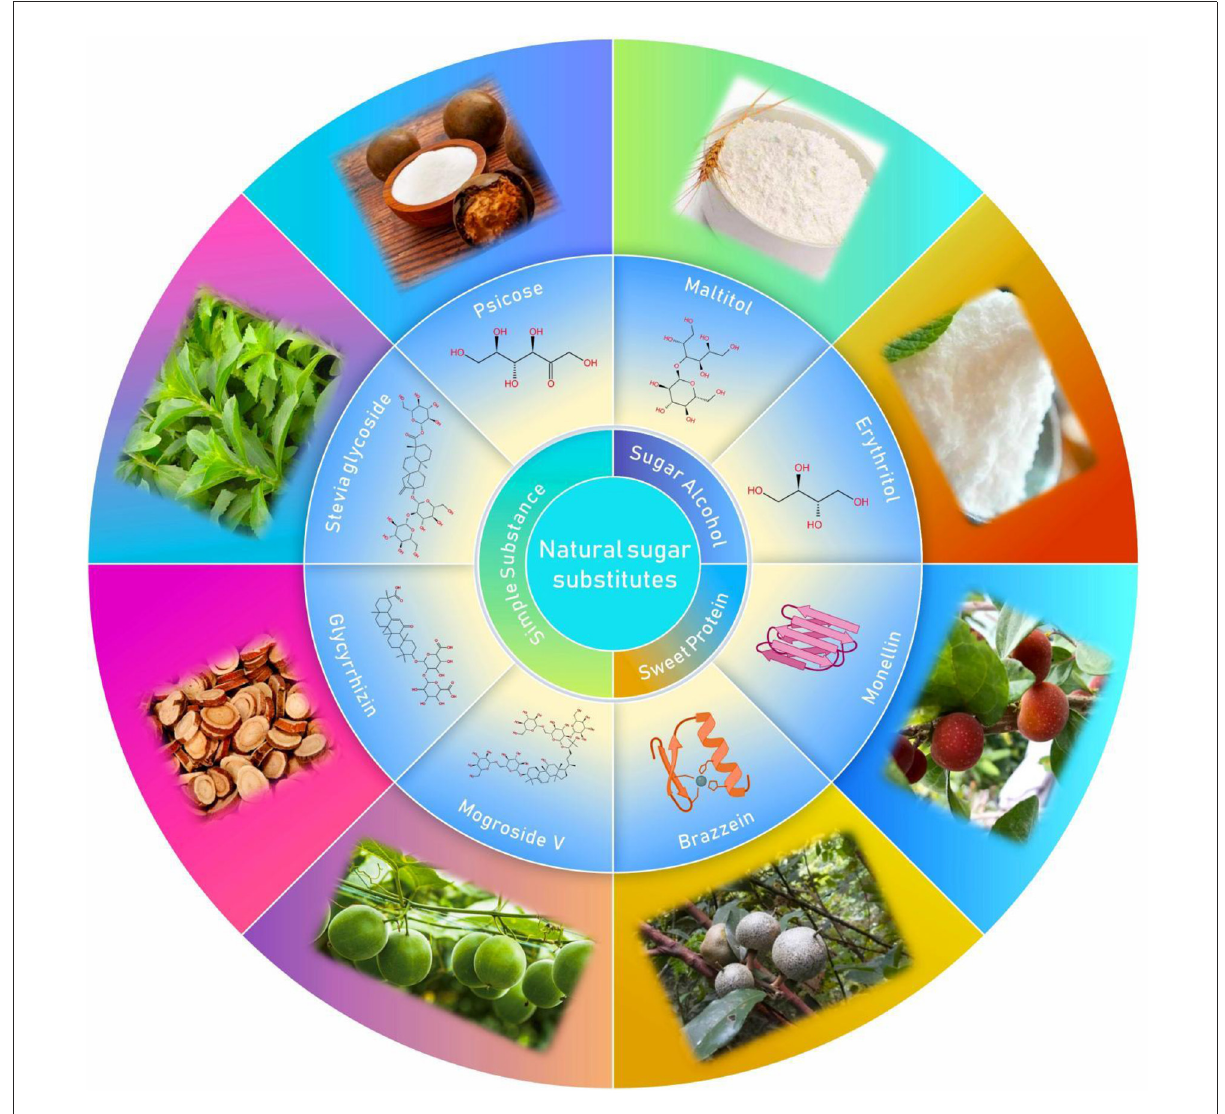
FIGURE4 Classification, structure and source of